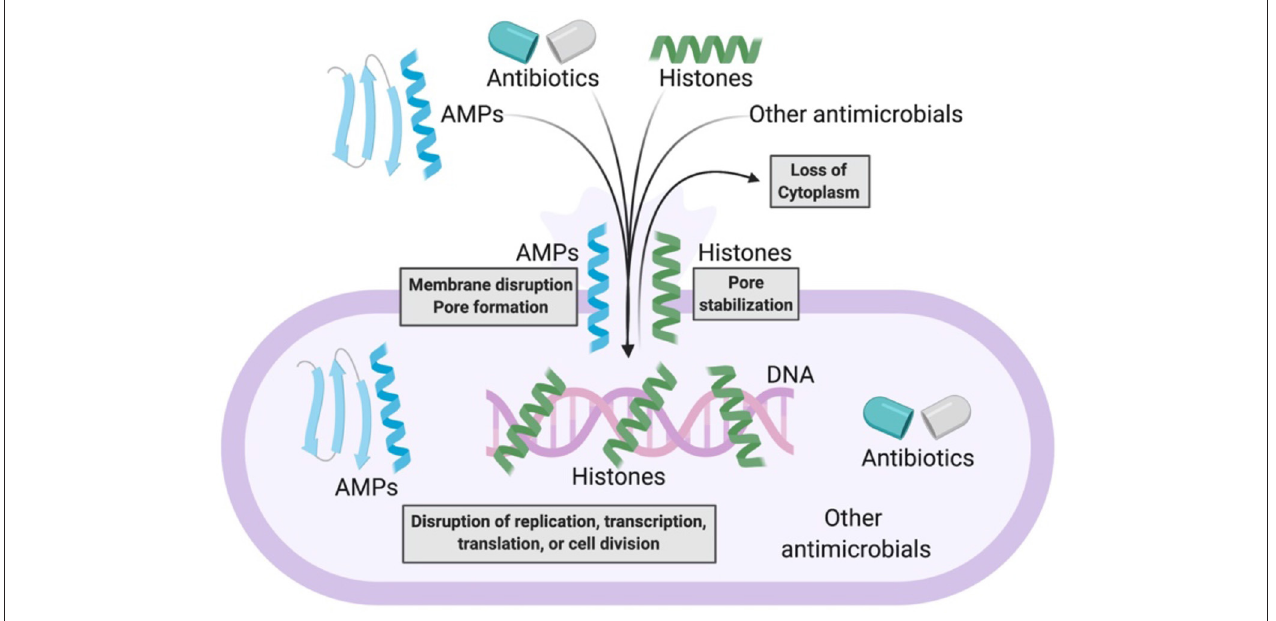
FIGURE 2 | Model of antimicrobial synergy between AMPs and other AMPs, antibiotics, histones, and other antimicrobials. AMPs form bacterial membrane pores or disrupt bacterial membranes. This enables the entry of more AMPs, antibiotics, histones, or other antimicrobials into bacteria. As a result, there is loss of bacterial cytoplasm and disruption of bacterial macromolecular functions. Histones potentially stabilize AMP-induced pores that enable further synergistic antimicrobial